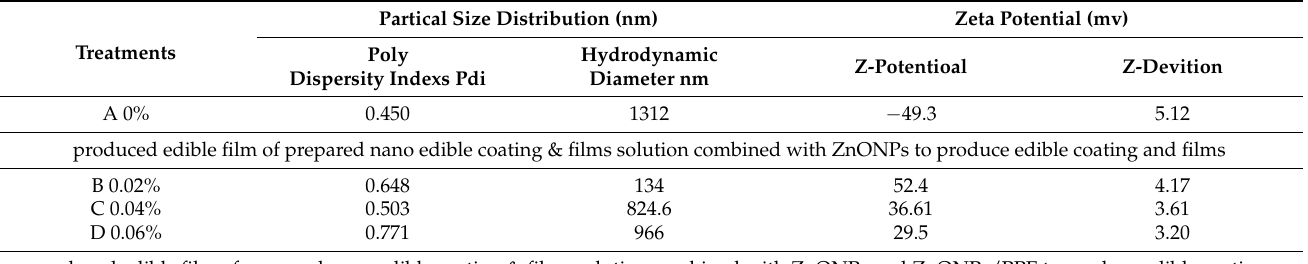
Table 4. Measured particle size and zeta potentioal of nanotechnology of prepared nano-edible coating and film solutions combined with ZnONPs and ZnONPs/PPE to produce edible coating and film solutions formed from